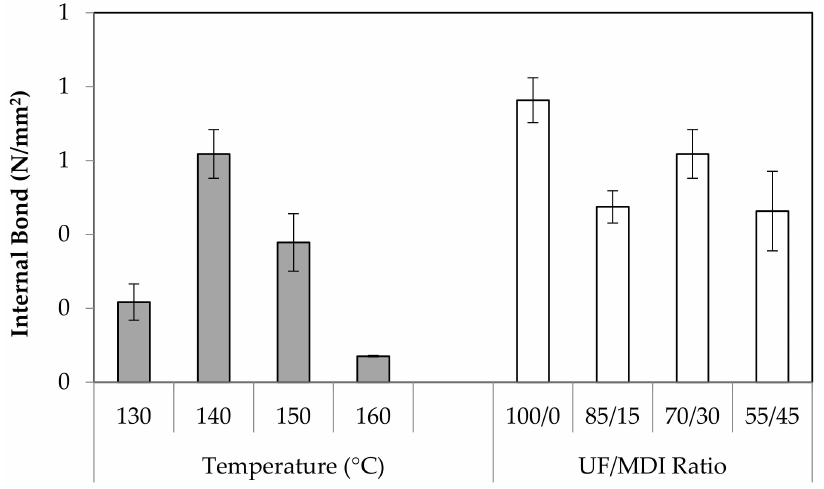
Figure 8. Internal bond of the particleboard. The bars indicate the standard